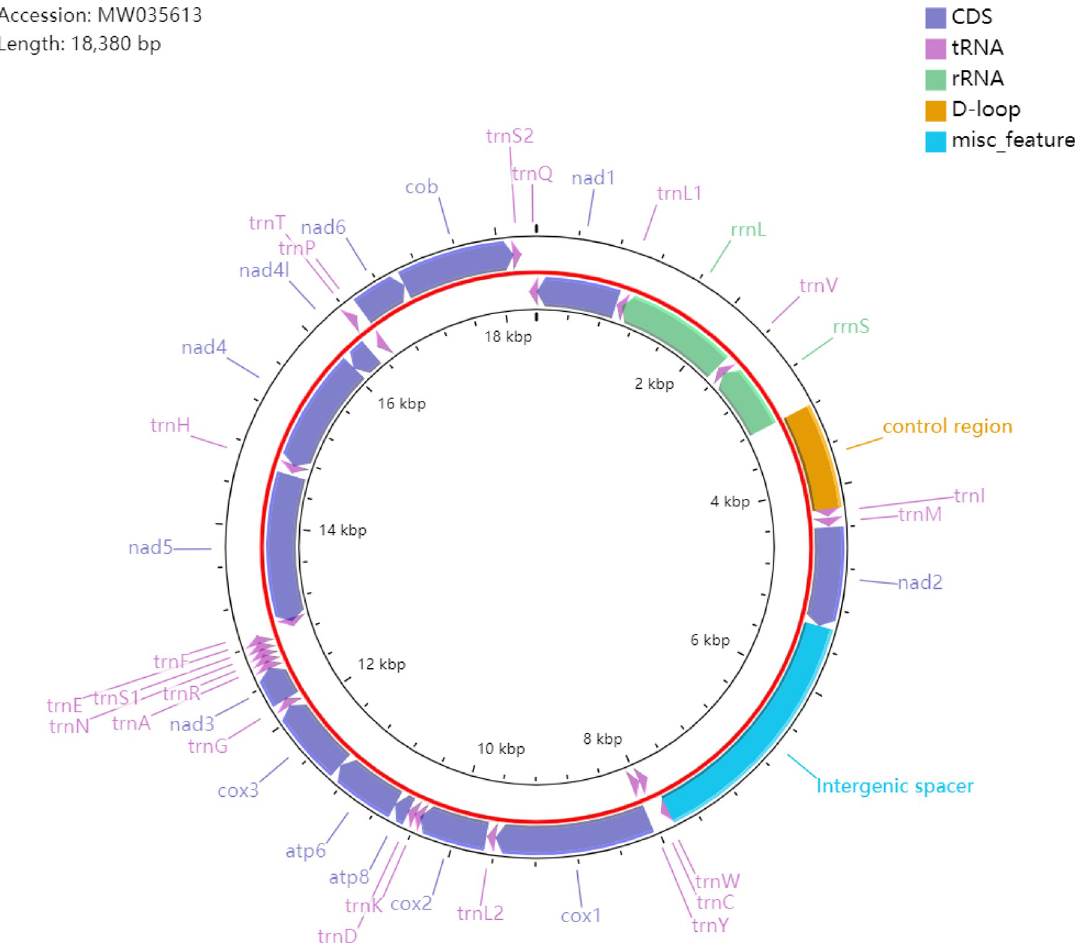
Fig 2. Organization of the mitogenome of Callosobruchus maculatus